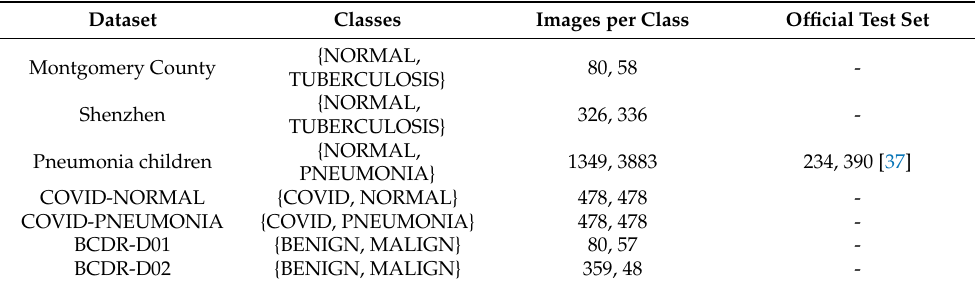
Table 2. Number of images of each class from each